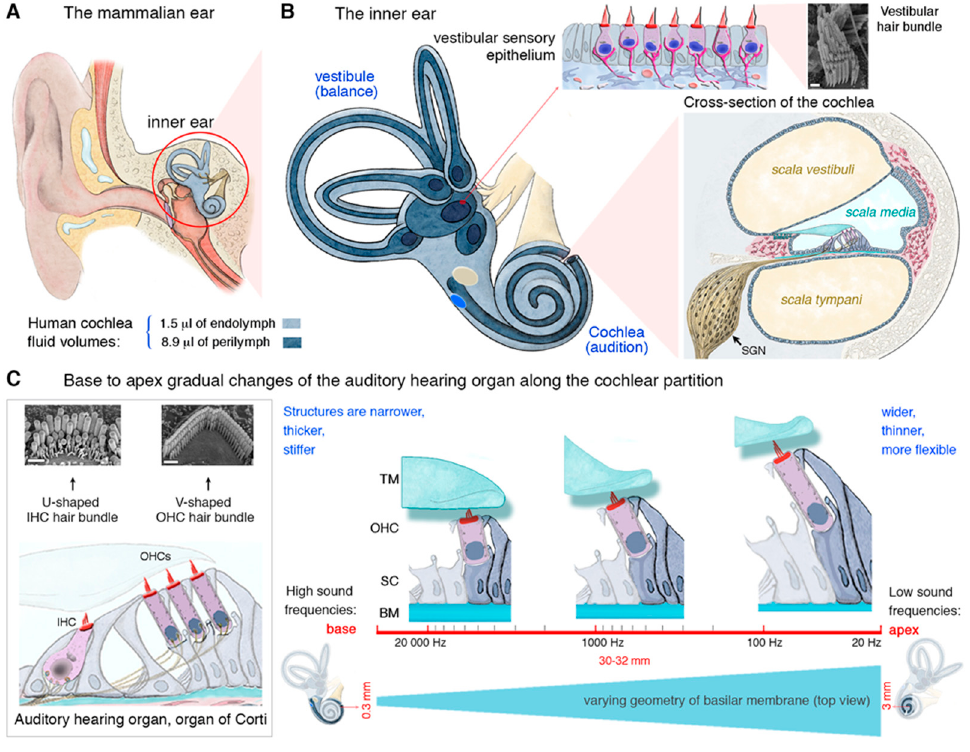
Figure 1. Mammalian inner ear anatomy and cochlear tonotopic organization. The mammalian inner ear consists of the vestibule (balance organs), which detect linear and angular accelerations, and the cochlea, the hearing organ, which detects sound waves. ( A,B ) The cochlea is made up of three fluid-filled compartments of differing ionic compositions— scala vestibuli (perilymph), the scala media (endolymph), and the scala tympani (perilymph). Sound conversion into electrical signals requires three major types of functional cells: hair cells (purple), supporting cells, and spiral ganglion neurons (yellow). ( C ) The auditory sensory organ, the organ of Corti, is made up of one row of highly organized inner hair cells (IHCs), three rows of outer hair cells (OHCs), flanked by various types of supporting cells. Along the cochlea, the hair cells, underlying basilar membrane (BM), surrounding, and overlying tectorial membrane (TM) are optimized to perceive specific and characteristic sound frequencies, defining a cochlear tonotopy that is preserved up to the auditory cortex. The structural and physical properties of the cochlea vary from base (shorter and stiffer cells) to apex (longer and more flexible cells). The cochlear base mainly perceives high-frequency tones (up to 20 kHz in humans), while the apex detects low-frequency sounds (20 Hz in humans). Scale bar in B, C: 1 μ m.